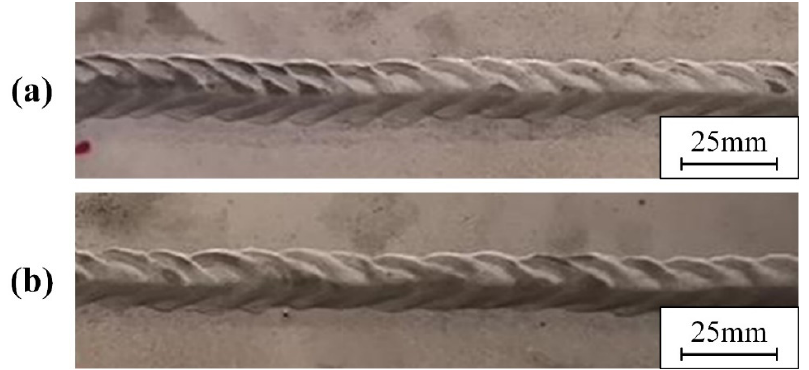
Figure 17. The result of the permeation testing: ( a ) black ash without laser cleaning; ( b ) black ash with laser cleaning.